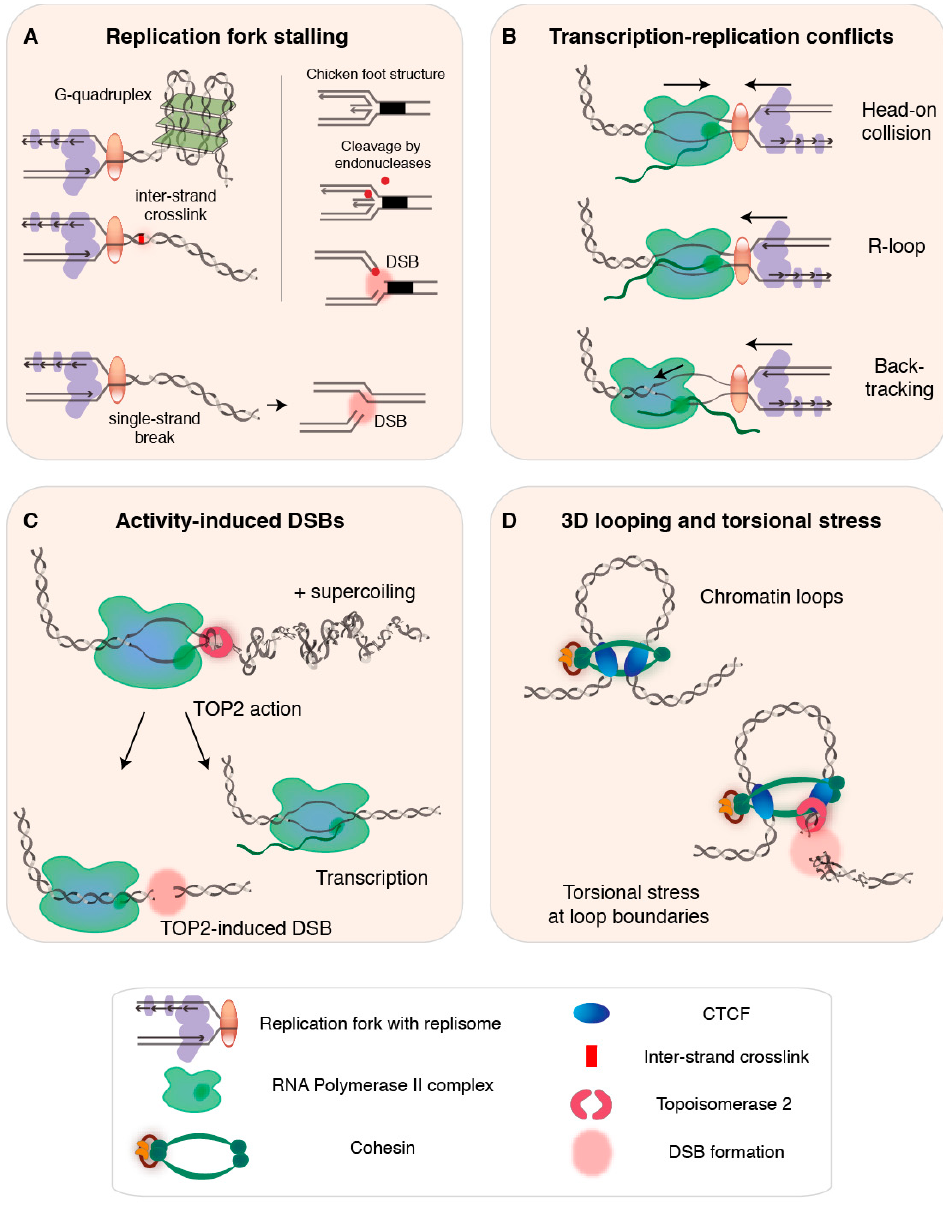
Figure 1. Endogenous DNA double-strand breaks (DSBs) during DNA transactions. ( A ) Left panel: during DNA replication, pre-existing DNA lesions such as G-quadruplexes and inter-strand crosslinks invoke replication stress and cause replication fork stalling. Right panel: an example of how intermediate structures during fork remodeling can lead to formation of a single-ended DSB. Bottom: replication through a single-strand break or nick can result in a single-ended DSB [36,39,41]. ( B ) Transcription complexes obstruct replication fork progression, particularly when transcription-replication encounters are head-on (top) [68], when the nascent RNA has formed an R-loop that stabilizes the RNAPII association with the DNA (middle) [62], and when the RNAPII complex is paused and displays backtracking (bottom, arrow indicates backward sliding of the RNAPII) [59]. ( C ) Transcription-related activity-induced DSBs emerge at sites of topoisomerase 2 (TOP2) action [56,71], which is required to release positive (+) supercoiling building up ahead of the RNAPII complex. TOP2-mediated DSBs enable transcription but can also lead to non-resolved DSBs when repair is escaped or fails [72]. ( D ) Genomic regions involved in 3D genome looping experience torsional stress that requires TOP2 activity to be resolved [73]. As a result, chromatin loop boundaries or anchors may accumulate TOP2-dependent DSBs